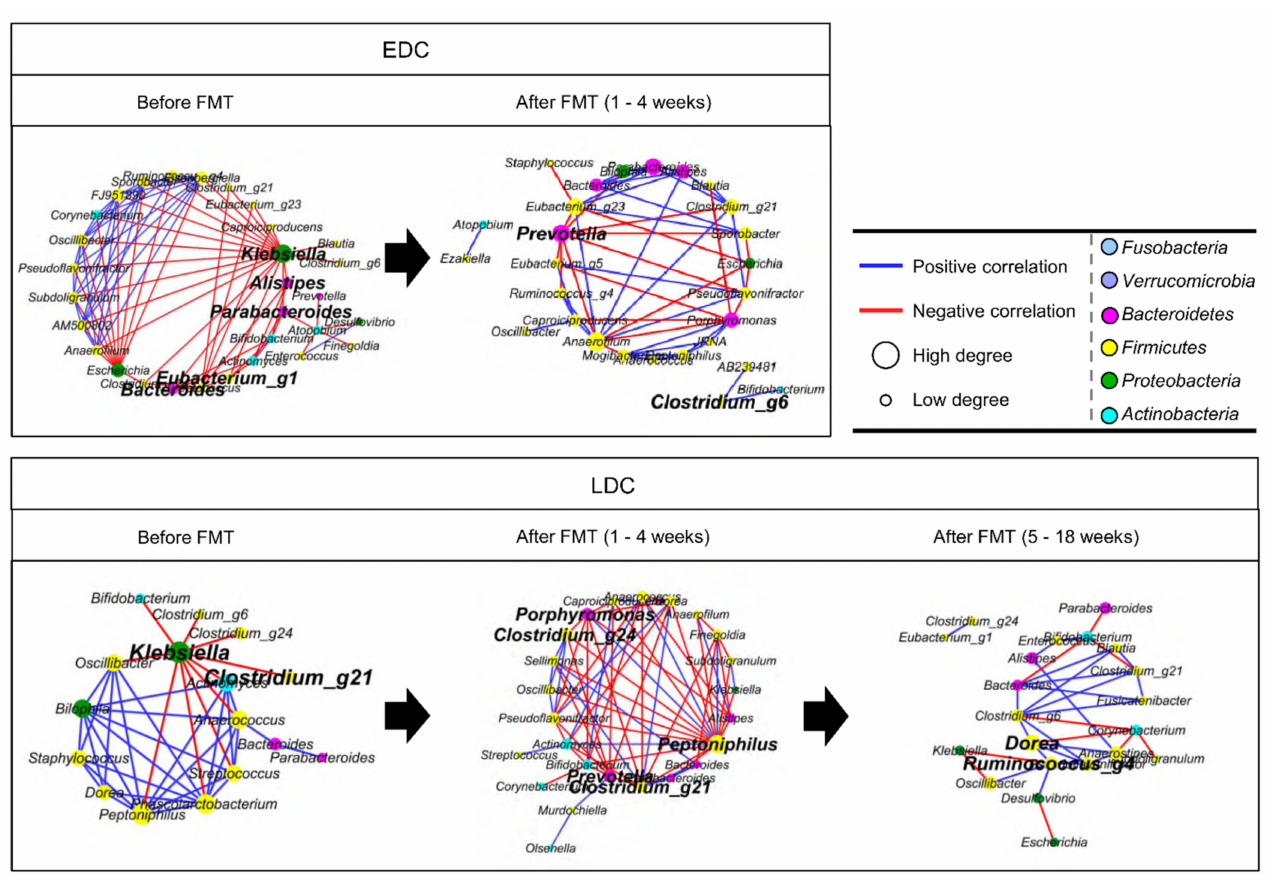
Figure 4. Correlations of genera in gut microbiota were compared between the EDC and LDC groups before and after FMT treatments using co-occurrence network analysis (corrected p < 0.01). Bold letters indicate keystone genera. Keystone genera were selected based on closeness centrality and betweenness centrality values. Circle size indicates the degree. Blue line: positive correlation; red line: negative correlation. EDC, early decolonization; LDC, late decolonization; FMT, fecal microbiota